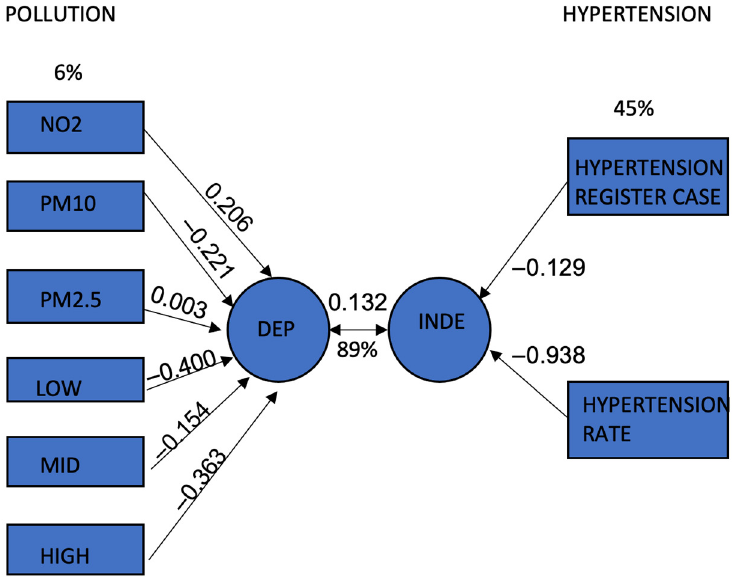
Table 5. Canonical correlation and Eigen values.